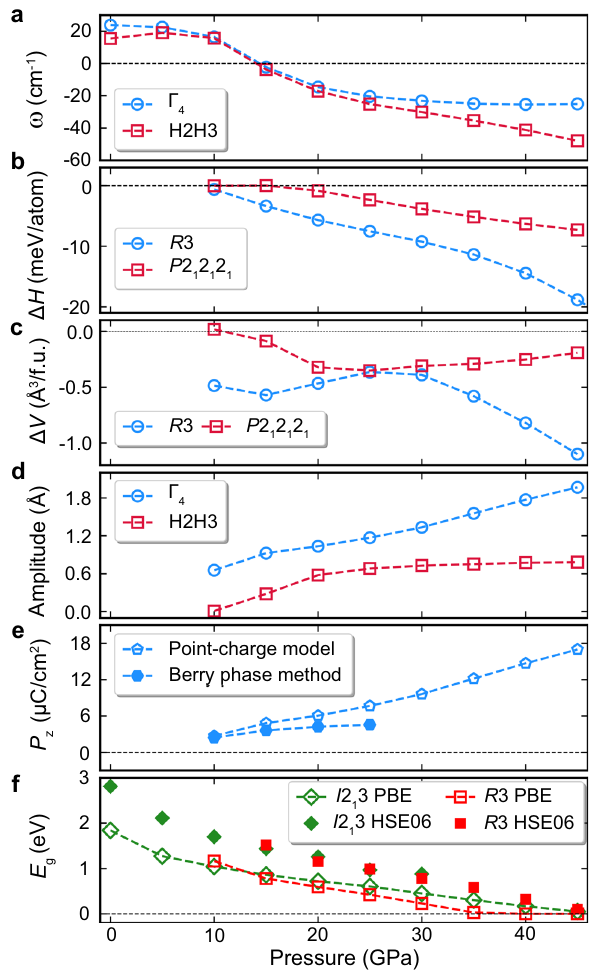
Fig. 6 Evolution of crystal structures and physical properties of Hg 3 Te 2 Cl 2 as a function of pressure. a Frequency of ferroelectric mode Γ 4 of I 2 1 3 phase of Hg 3 Te 2 Cl 2 . b Enthalpy difference ( Δ H ) of R 3 and P 2 1 2 1 2 1 phases with respect to cubic phase I 2 1 3. c Volume change ( Δ V ) of R 3 and P 2 I 2 1 2 1 2 1 phases with respect to the cubic phase 1 3. d Distortion amplitude of Γ 4 (connected with R 3 phase) and H2H3 (connected with P 2 1 2 1 2 1 ) modes of I 2 1 3 phase of Hg 3 Te 2 Cl 2 . e Spontaneous polarization of R 3 phase along the c -axis calculated by using Berry Phase method and point charge model. f Band gaps of I 2 1 3 and R 3 phase of Hg 3 Te 2 Cl 2